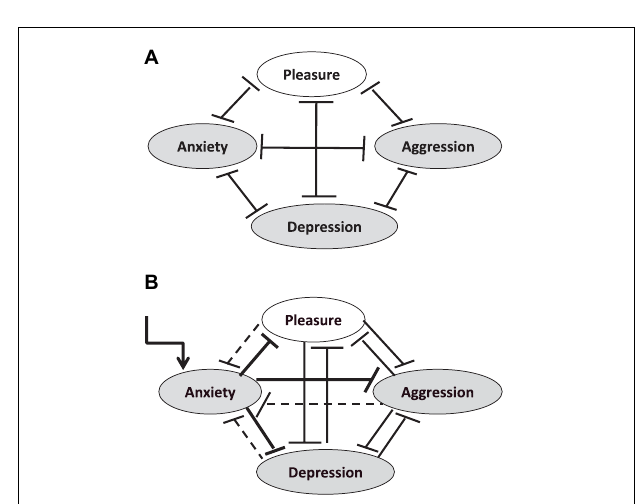
FIGURE 11 | Hypothetical network of basic emotions with reciprocal inhibitions. (A) Balanced network with reciprocal inhibitions. Also co-activation can occur by dis-inhibitory feedbacks via double inhibition. For simplification bidirectional arrows are used. (B) Anxiety-specific stimulation evokes strong multilateral inhibitions that in consequence enforce anxiety by weaker inhibitory feedback. Unidirectional arrows are used